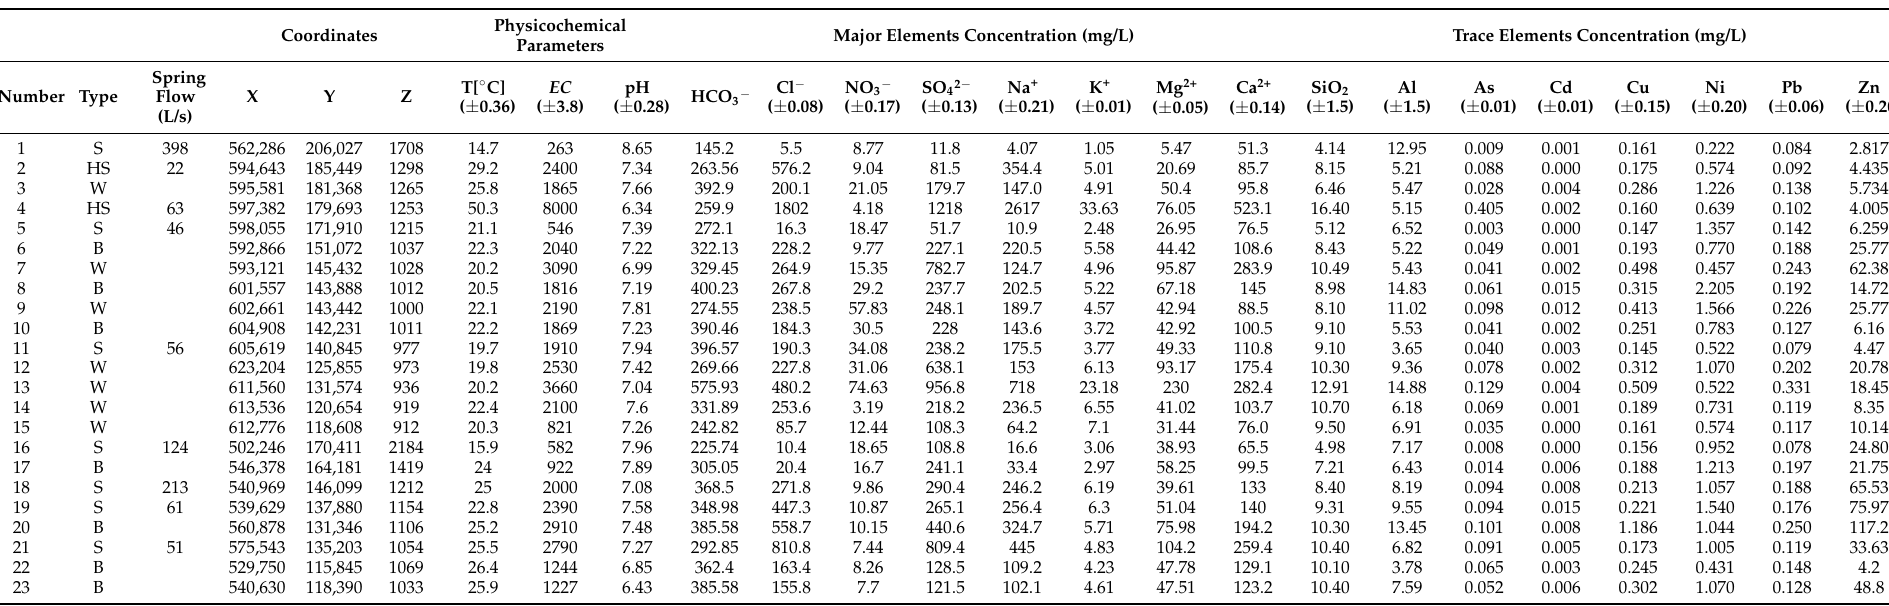
Table 1. Results of analysis of water samples in the study area with average uncertainties (W: wells; B: boreholes; HS: hot springs; S: cold springs) collected